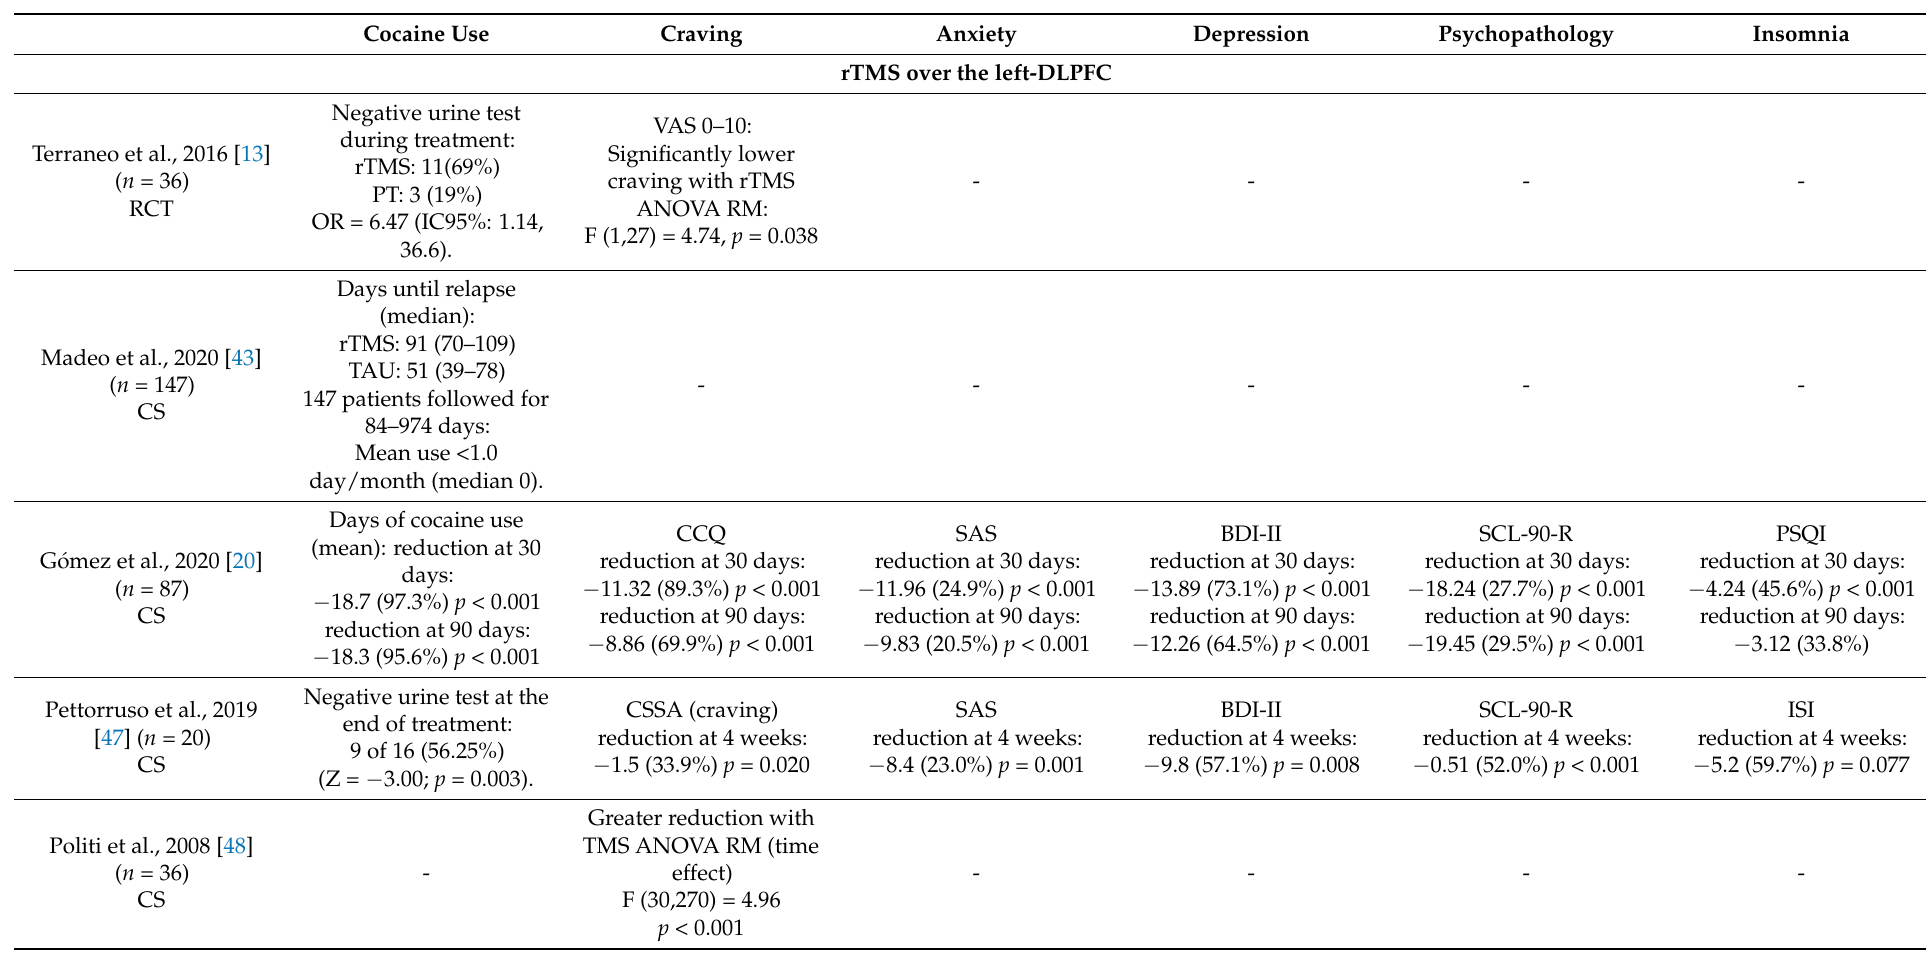
Table 3. Effectiveness results among the included